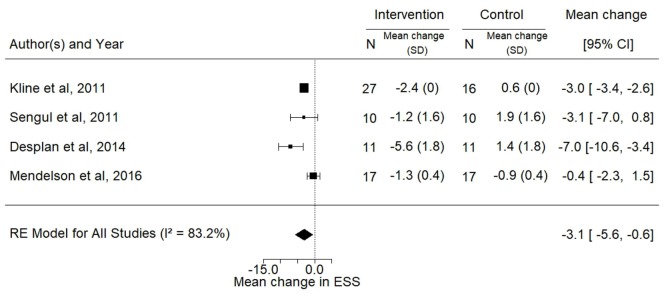
Forest plot for the mean change in Epworth sleepiness scale following exercise training. The diamond reflects the 95% confidence interval of the pooled estimate of mean difference. Ref (16, 22, 30, 33).